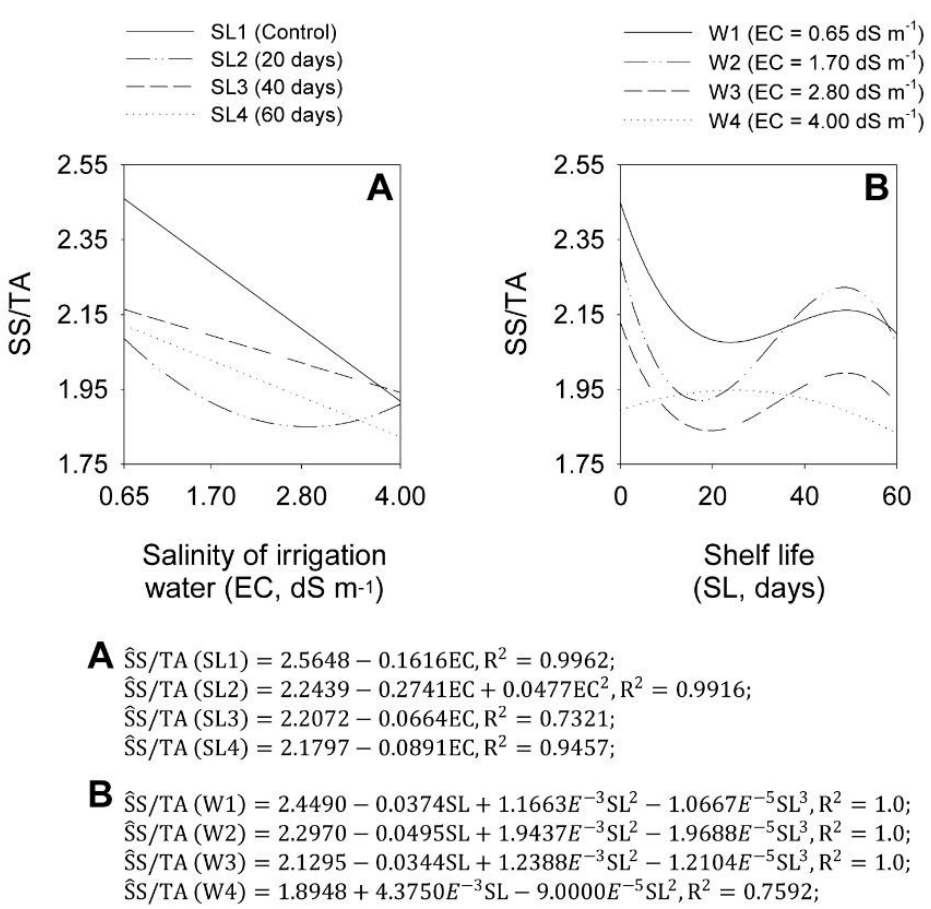
Figure 7. Effect of the interaction between salinity of irrigation water levels (EC) ( A ) and shelf life (SL) ( B ) on the variable SS/AT in ‘Rio da Antas’ onion bulbs.